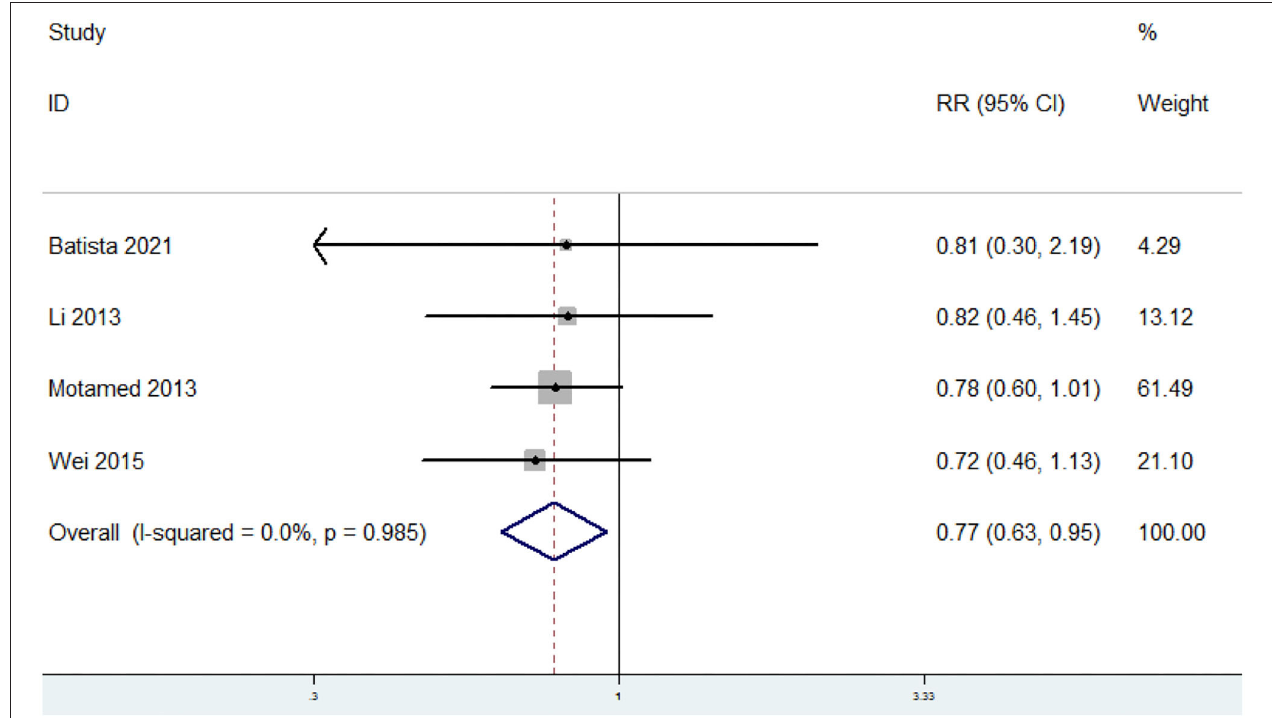
FIGURE 4 | Forest plot of meta-analysis: Overall multi-variable adjusted RR of MetS for the highest vs. lowest dietary selenium level.